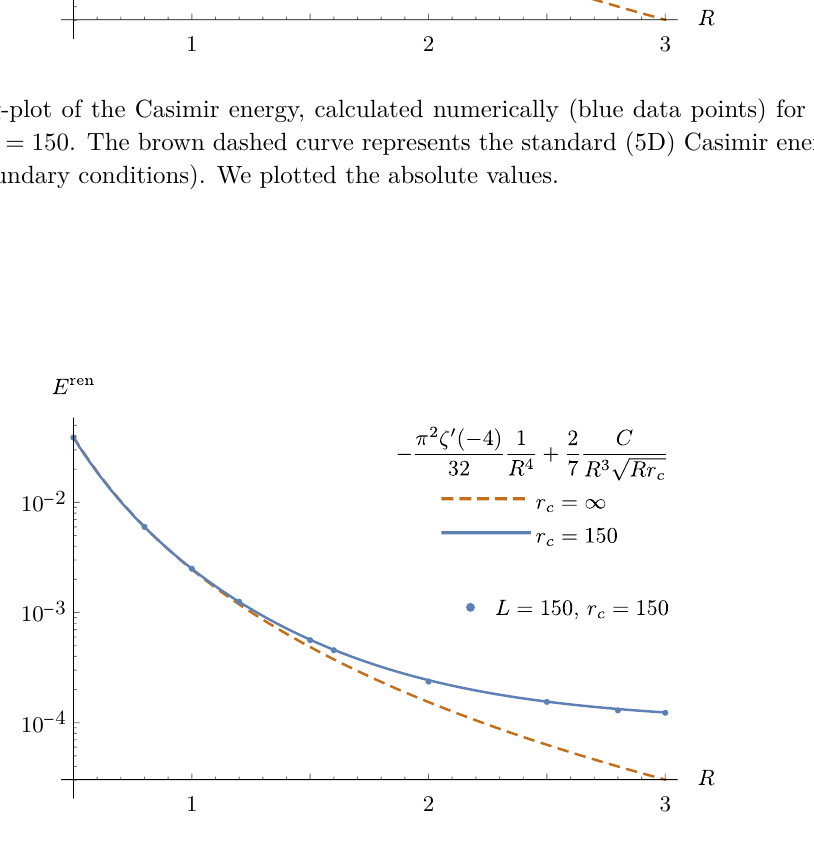
Figure 10 . This log-plot shows the Casimir energy (blue data points) for the parameters a = 0 . 1 , r c = 150 and L = 150 . Also shown is the plot of the function, stated in the plot legend, that was fitted to the data points thereby determining the coefficient C . We suppress here the constant shift, which we had to apply to the curve in order to fit the points. The brown, dashed curve represents the standard (5D) Casimir energy (due to Dirichlet boundary conditions). We plotted the absolute